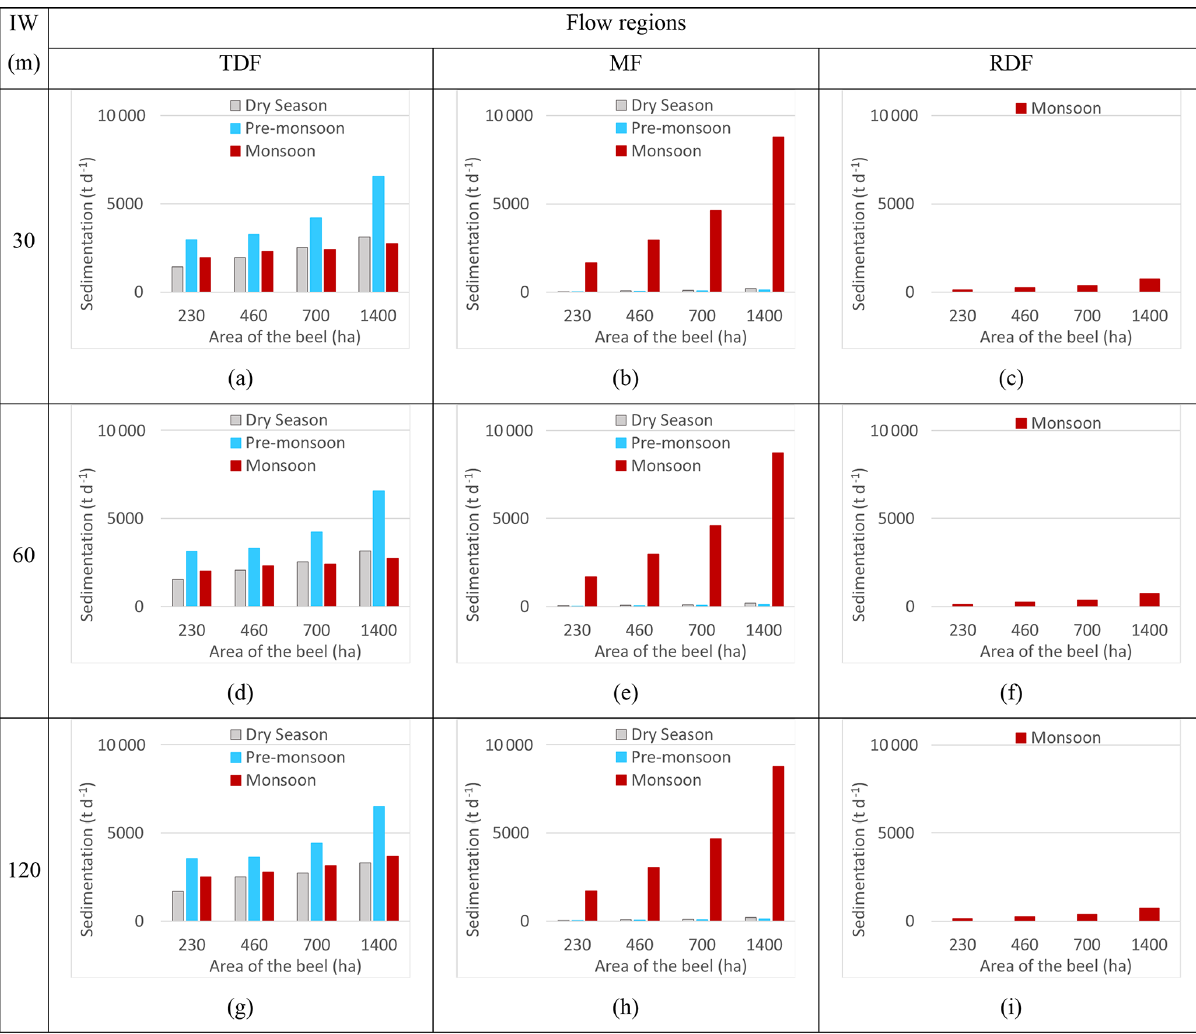
Figure 4. Sediment deposition simulated with the 2D hydro-morphodynamic model for three different inlet widths (IW), three different flow regions (TDF – tide dominated flow; MF – mixed flow; RDF – river-dominated flow), four different beel surface areas (BAs), and three different